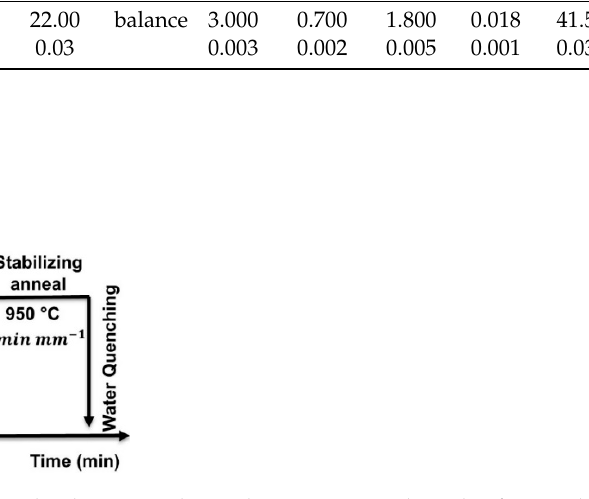
Table 1. Chemical composition of Alloy 825 used in the current investigation (wt. %). Combustion analysis was used for carbon and nitrogen and X-ray fluorescence spectrometry was used for all other elements in accordance with the relevant standards. Table 2. Sample designations used in the present work.